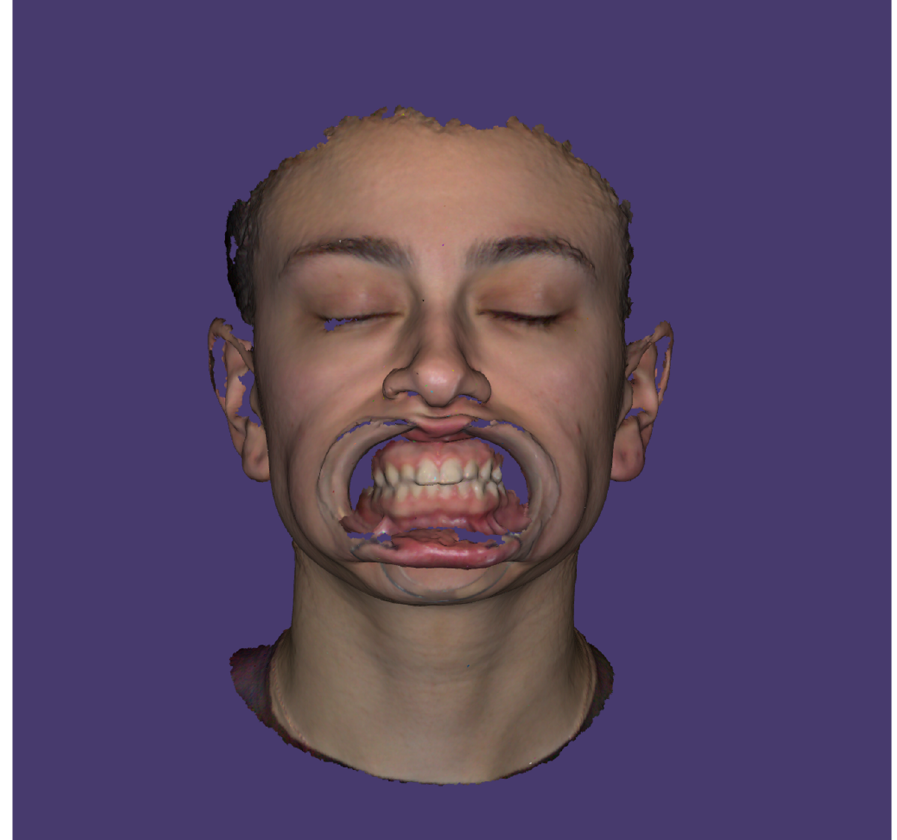
Figure 4. Face scan using a lip-and-cheek retractor.